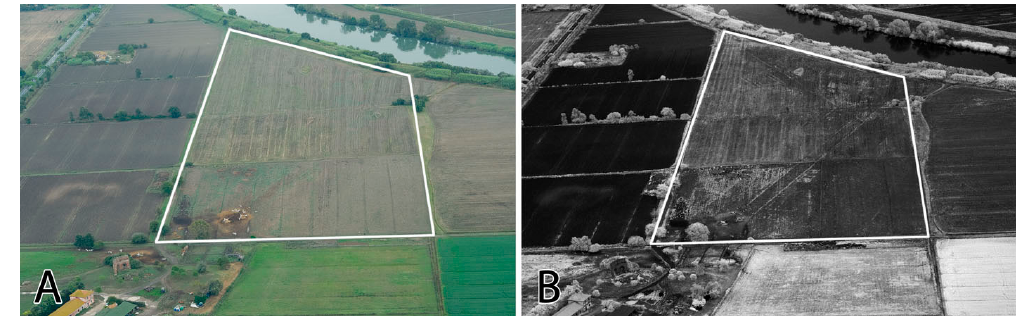
Figure 6. Visible ( A ) and NIR photograph ( B ) of the same area in Portus , Italy (N 41°46 ′ 30 ″ , E 12°15 ′ 51 ″ —WGS84). Note the many features that are visible in the NIR image but go undetected in the conventional photograph.